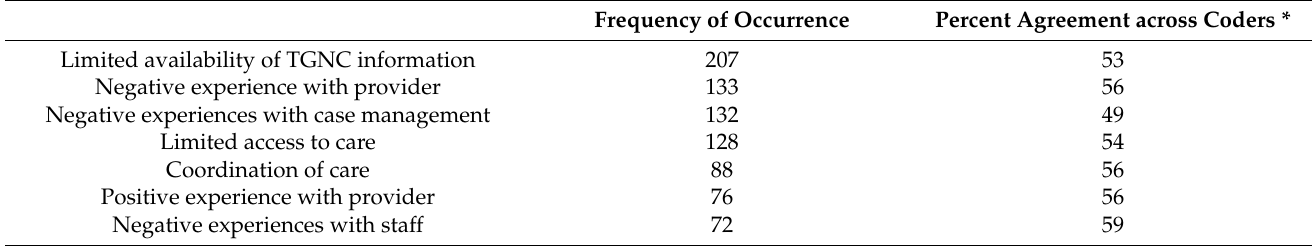
Table 4. Predominant transgender patient focus group themes.